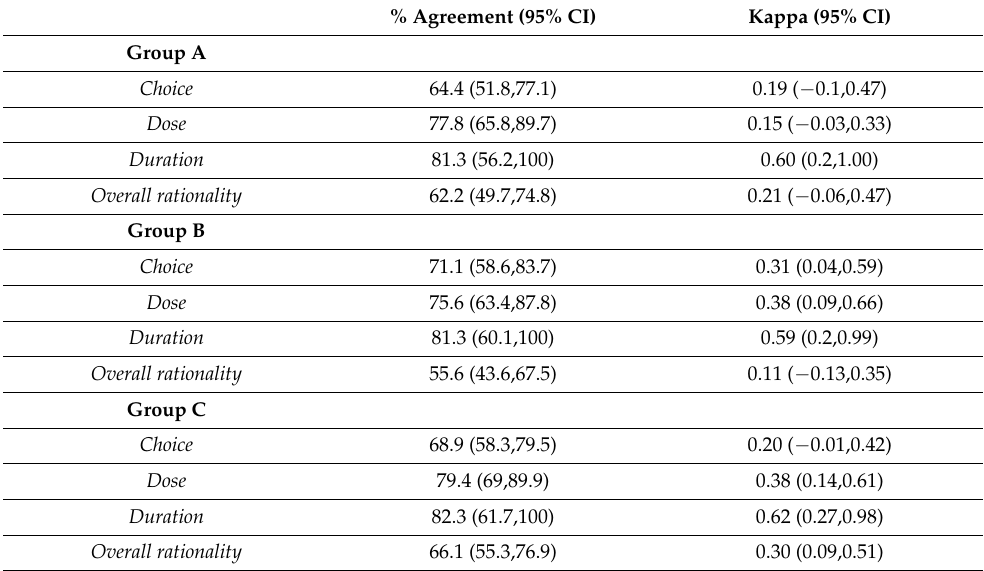
Table 2. Group-specific inter-rater reliability